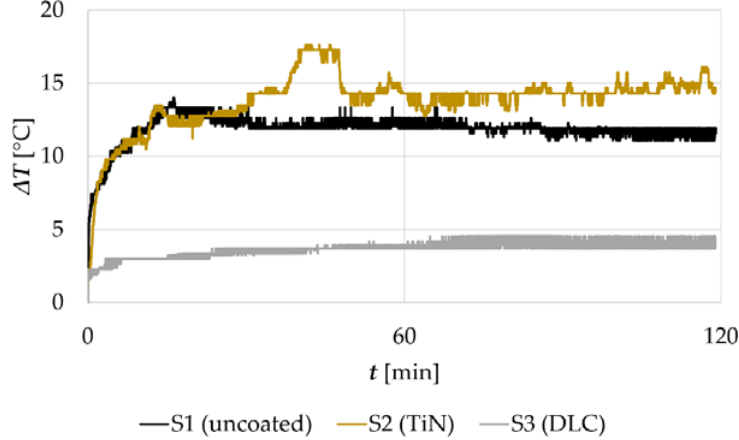
Figure 6. Friction-induced temperature oscillations in time, registered for sample series S1, S2, and S3. Please note that the presented temperature alterations were recorded simultaneously with data presented in Figure 2.